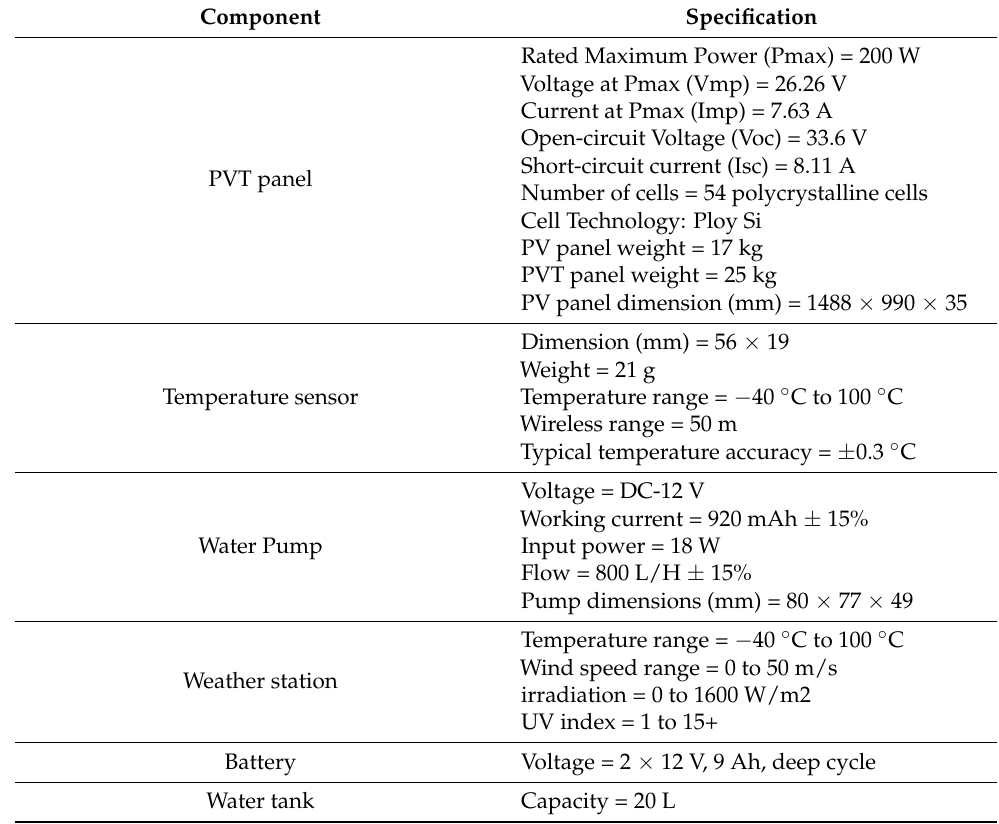
Table 1. PVT system test rig major